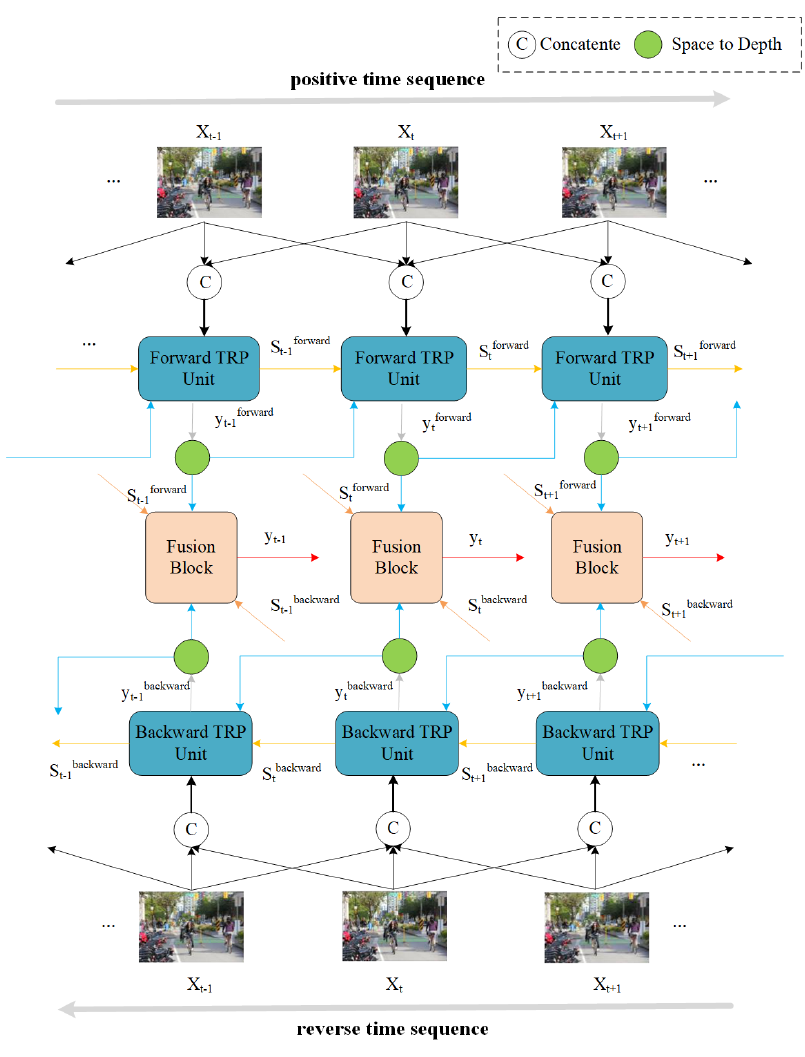
Figure 1. Bidirectional temporal-recurrent propagation network (BTRPN) network